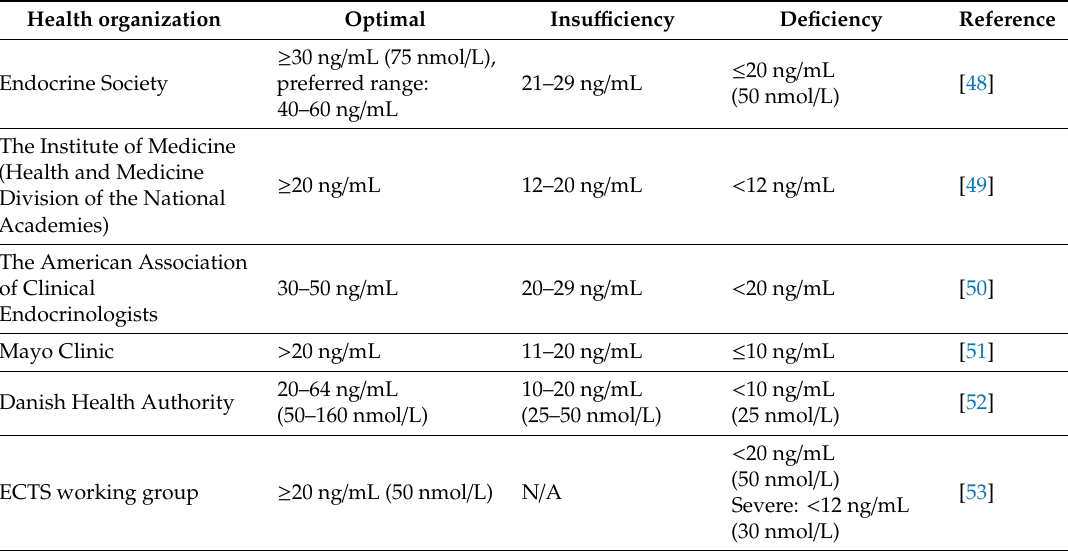
Table 4. Definition of Vitamin D status (25(OH)D concentration) by di ff erent health